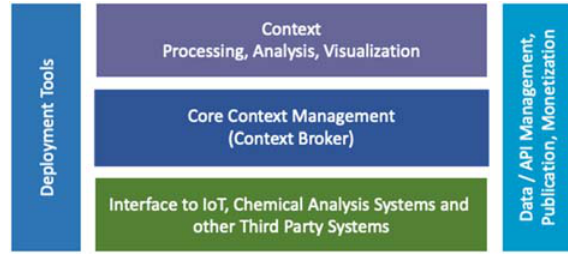
Figure 3. FIWARE architecture.